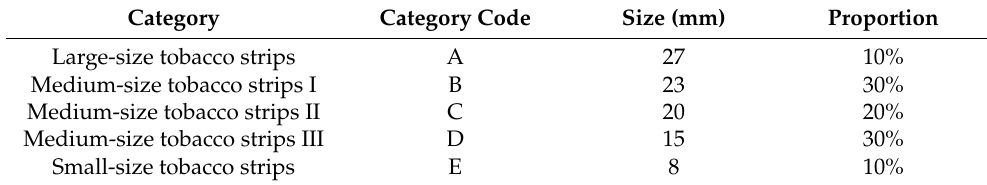
Figure 1. Real tobacco strips and corresponding models.